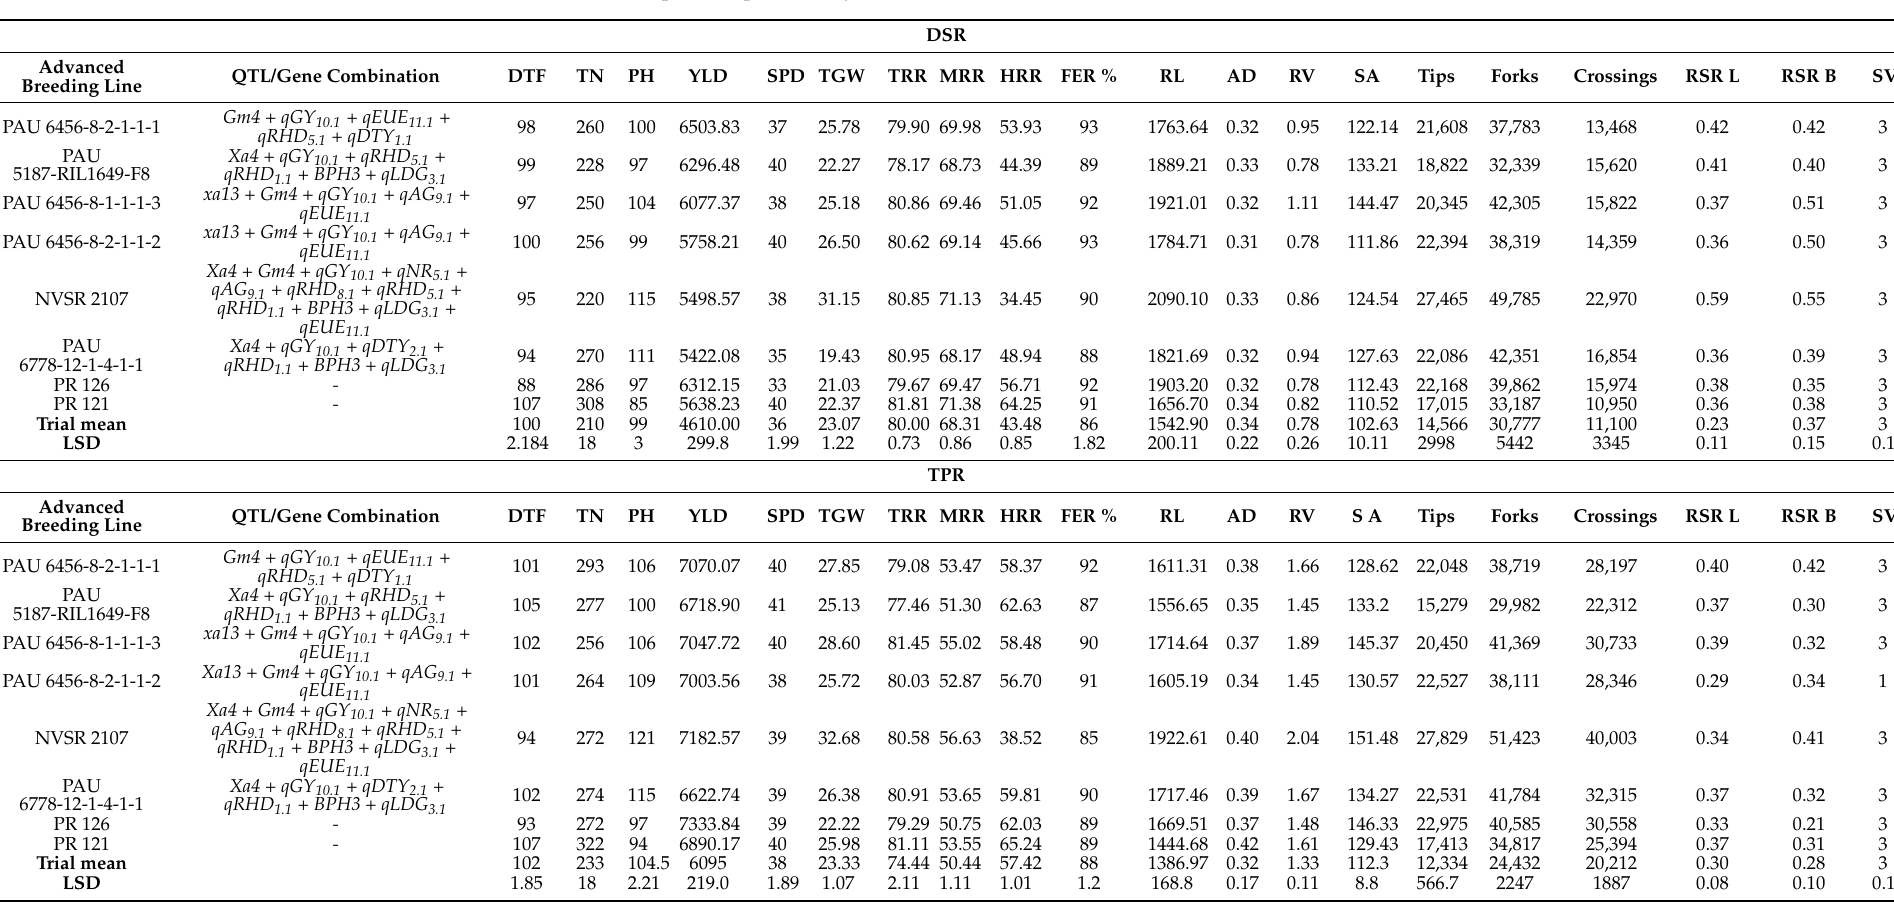
Table 5. The performance of selected advanced breeding lines in terms of morpho-physiological traits, grain yield, and yield-related traits, and root architecture traits under direct seeded and transplanted puddled system of rice cultivation.